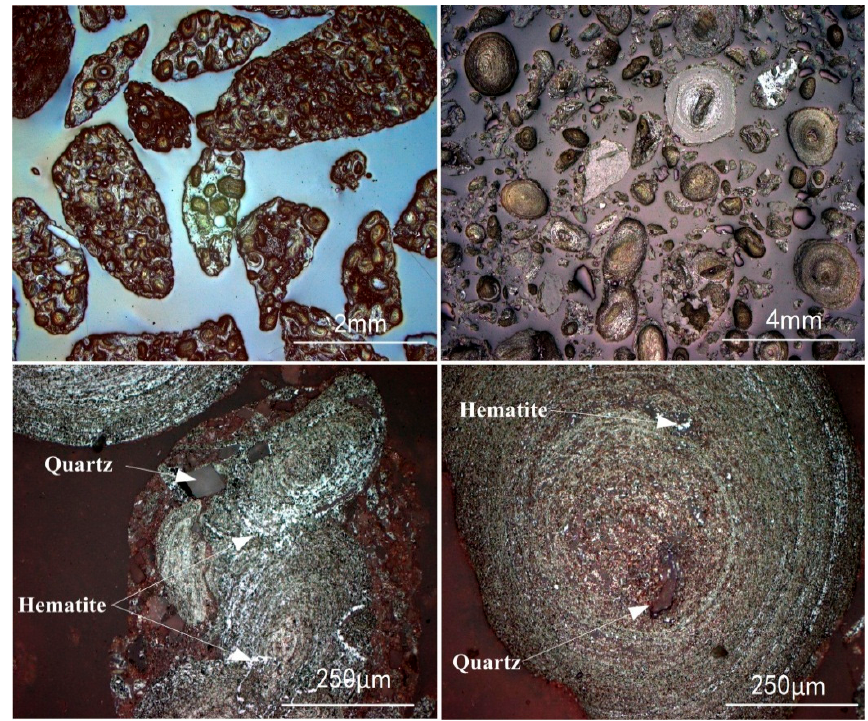
Figure 2. Optical microscope pictures of the oolitic hematite ore.